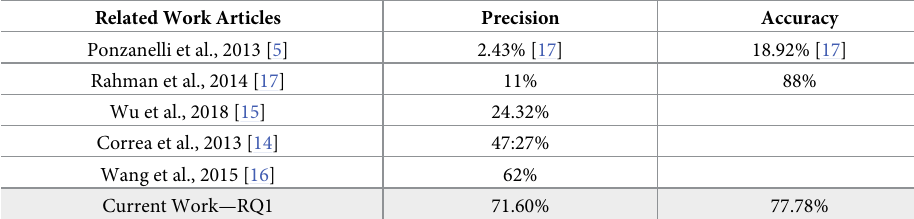
Table 6. RQ1 results and comparison with related